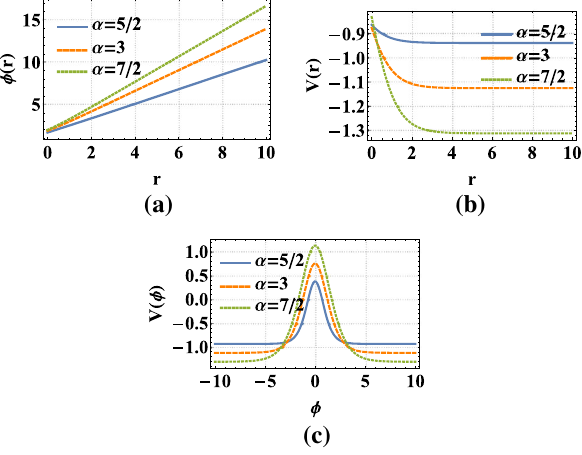
Fig. 2 The scalar field (35) and the scalar potential, (33) or (36), in the limit D → 4 for the first solution. a The scalar field φ( r ) . b The scalar potential V ( r ) . c The scalar potential V (φ) as a function of the scalar field. The parameters are set to k = 1 and C 1 = − 1 /( 1 − α/ 2